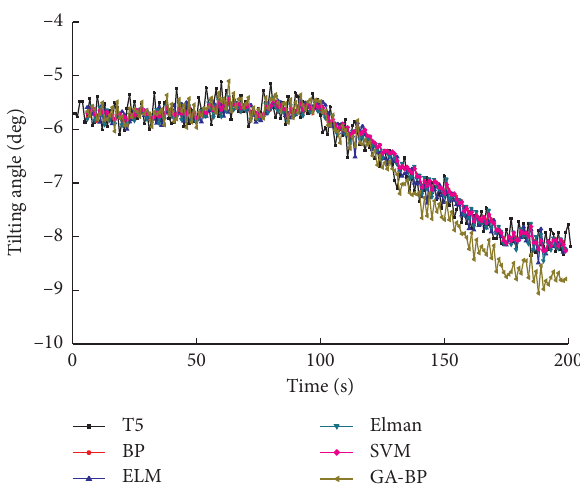
Figure 17: Fitting inclination angles through other models.